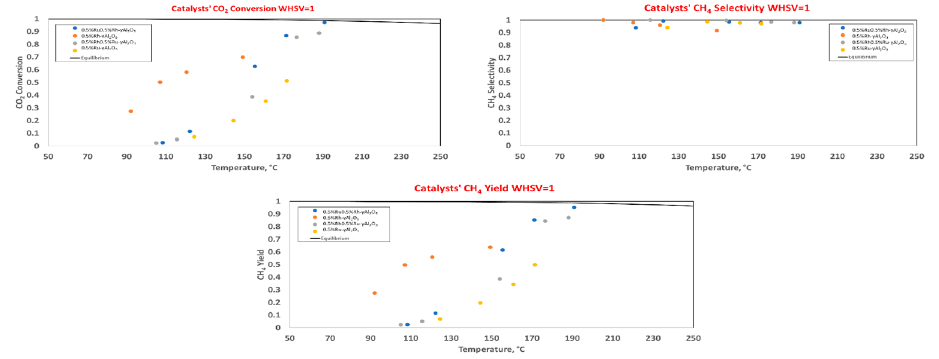
Figure 12. Catalysts’ CO 2 conversion, CH 4 selectivity and yield in non-thermal-plasma-assisted tests at WHSV = 1 NL/g cat h. at WHSV = 1 NL/g cat